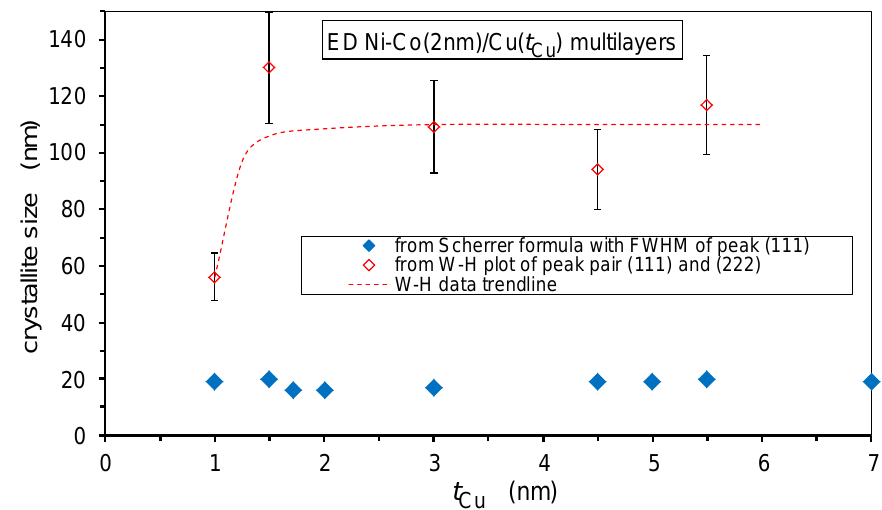
Figure 8. Crystallite size in the growth direction for the present Ni65Co35/Cu multilayers from the Scherrer formula (full diamond symbols) and from the W–H plots (open diamond symbols; the dashed line is just an estimated trendline).